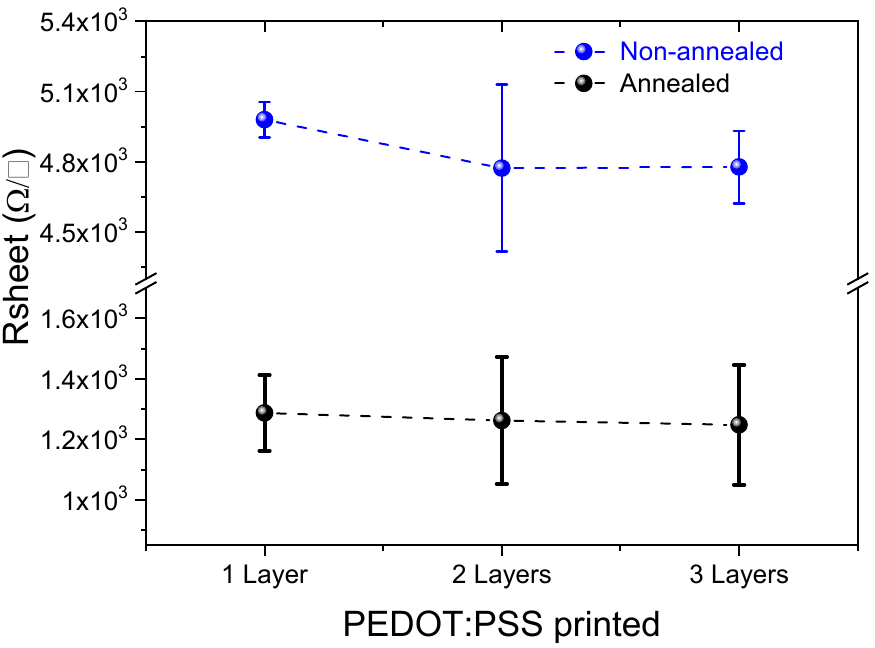
Figure 4. Van der Pauw measurements as a function of one, two, and three PEDOT:PSS ink layers.